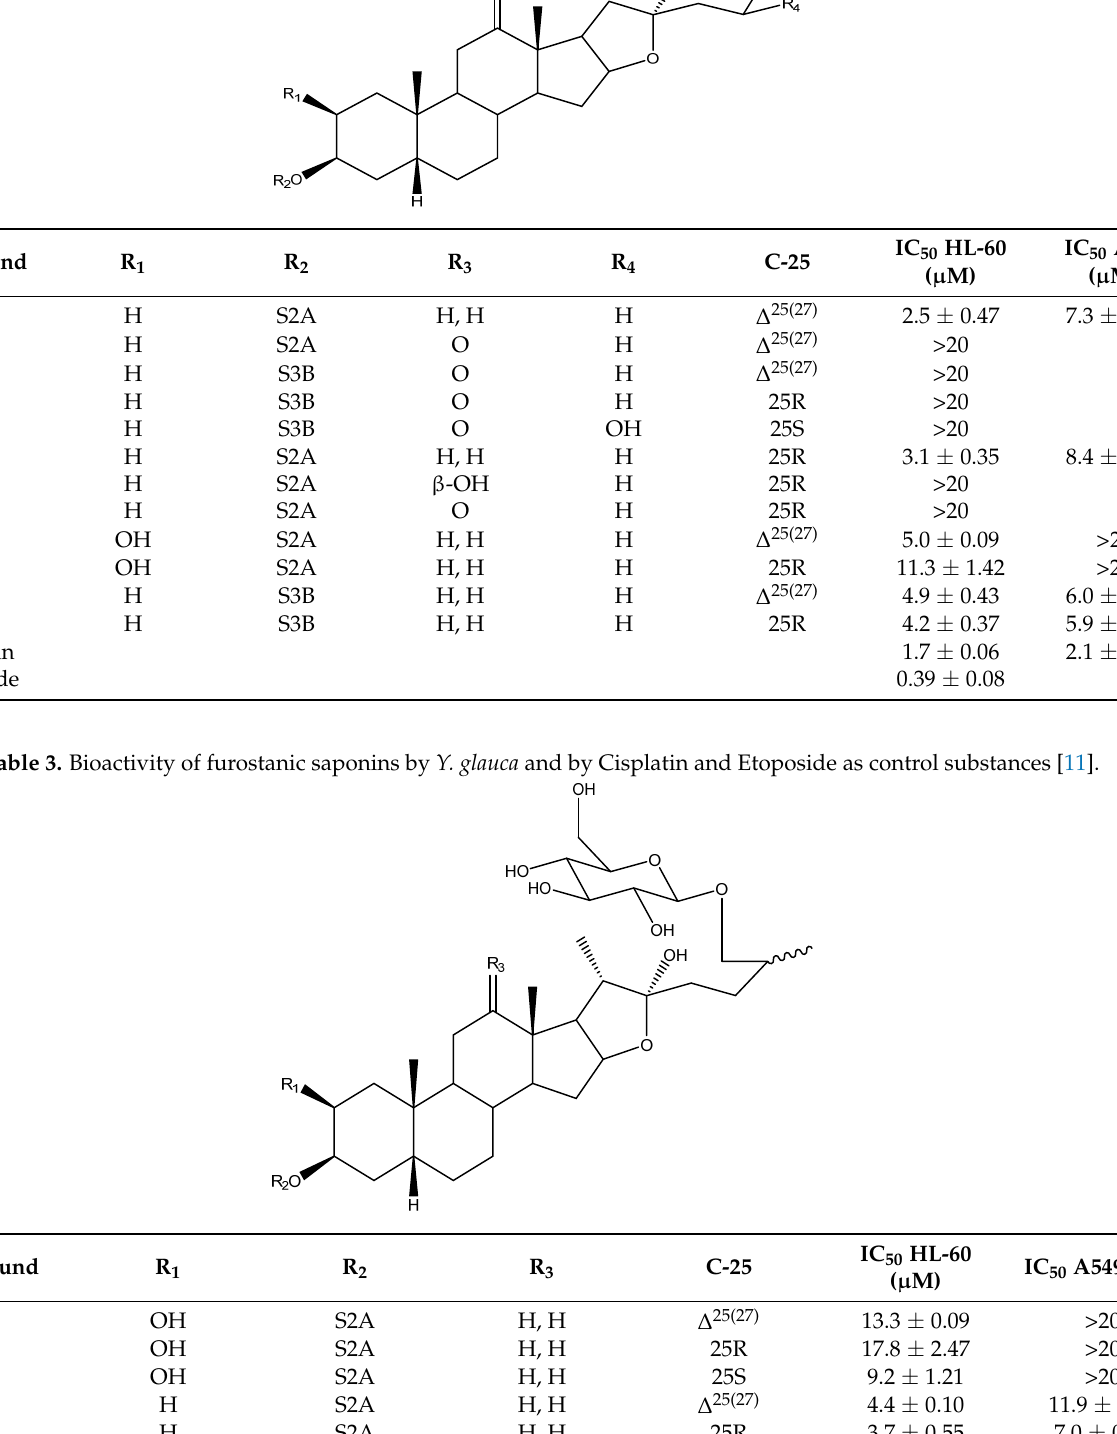
Molecules 2021 , 26 , x FOR PEER REVIEW